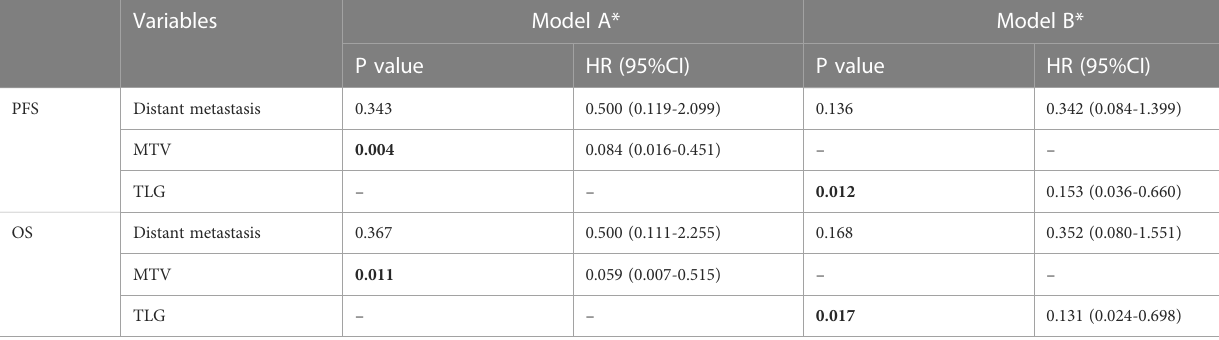
TABLE 5 Multivariate analysis for progression-free survival (PFS) and overall survival